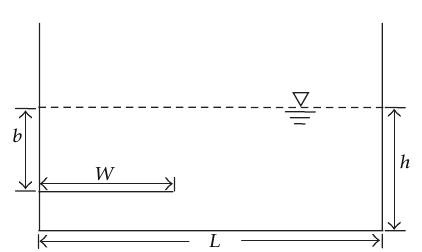
Figure 2: Rectangular tank with a horizontal ba ffl e.